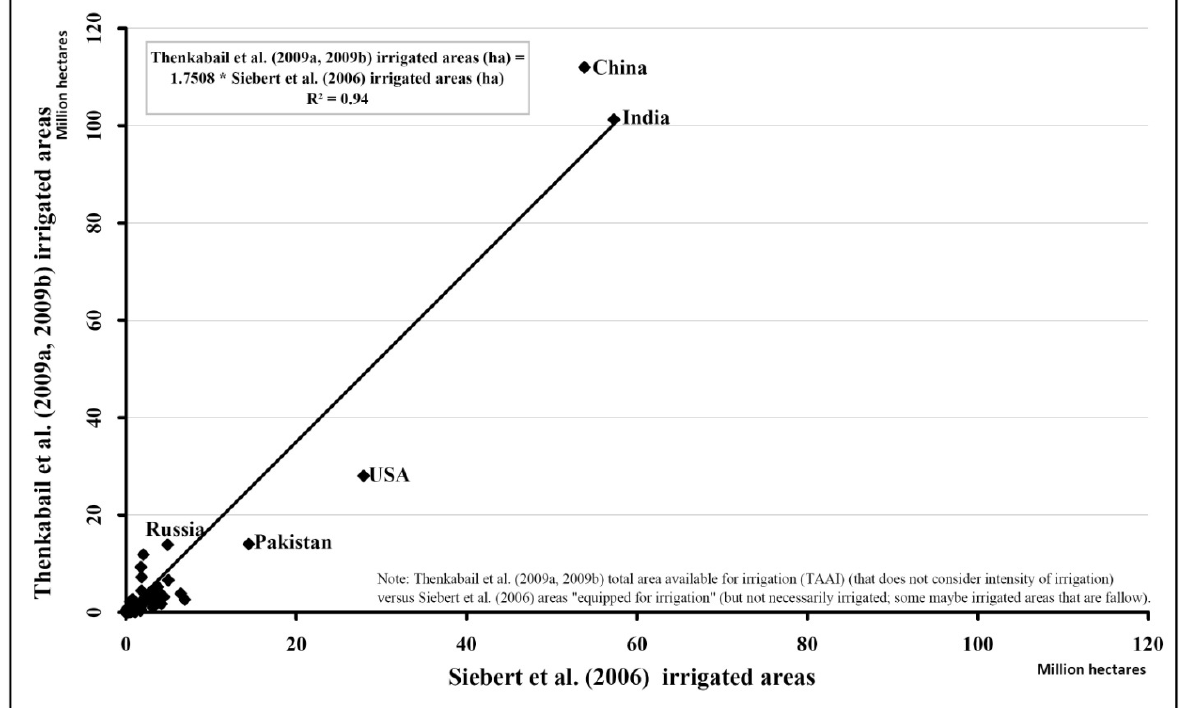
Figure 6a. Comparison of irrigated areas of 197 countries in the world [1,2, versus 52]. Irrigated areas derived by Siebert et al . [52] based primarily on non-remote sensing approaches, are compared with Thenkabail et al . [1,2], based primarily on remote sensing approaches. The total areas by Thenkabail et al . [1,2] estimates were significantly higher than Siebert et al . [52] mainly as a result of higher estimates for India and China. Overall, there is remarkably high correlation (R 2 value of 0.94) for the 1:1 line for a country-by- country comparison of irrigated cropland areas between the two approaches. The differences are larger than Figure 6b. Reasons for differences are discussed in the